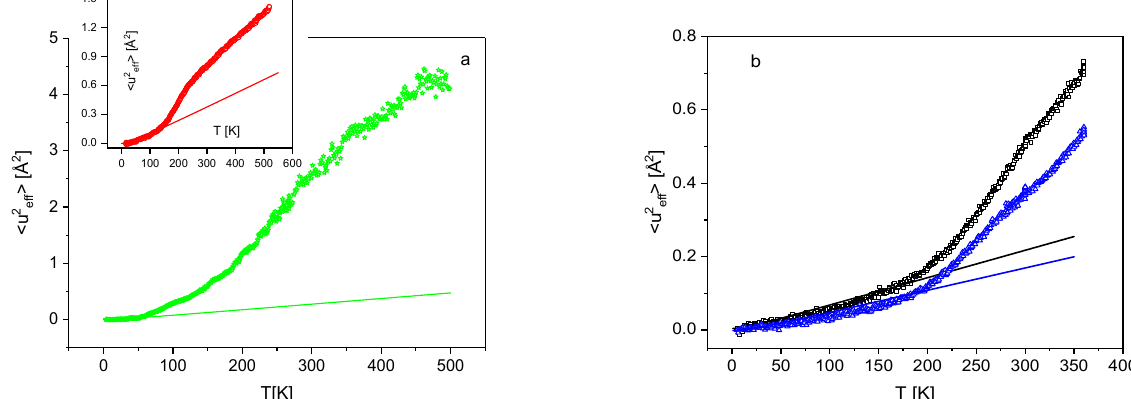
Figure 5. ( a ) Comparison of the measured effective mean squared displacement (green asterisks) with that calculated by Equation (5) (green line) for PTCNSi1. The inset shows the same for PIM-1: red circles -measured; red line calculated. ( b ) Comparison of the measured <u 2 eff > for PIM-EA-TB(CH 3 ) (black squares) and PIM-EA-TB(H 2 ) (blue triangles) with those calculated by Equation (5): black line—PIM-EA-TB(CH 3 ), blue line—PIM-EA-TB(H 2 ). In both ( a , b ) the <u 2 eff > values shown have the value due to the removed zero-point motion. Because the experiments start at a finite temperature, the experimental values of <u 2 eff > were shifted to coincide with the theoretical vibrational at the lowest temperature of the experiment.